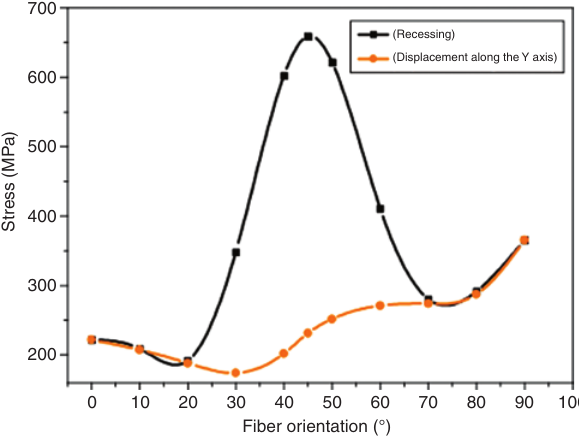
Figure 3: Evolution of the equivalent Mises stress depending on fiber orientations for a composite plate without cracks for two boundary conditions: recessed and (U2 = 0) displacement along the Y axis.